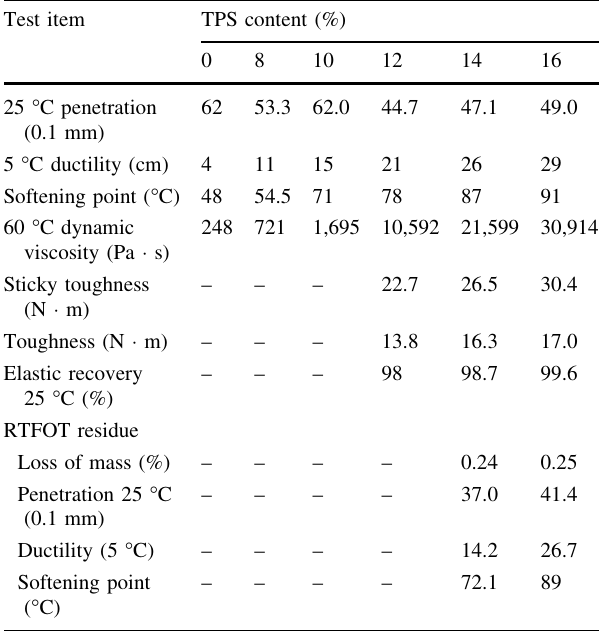
Table 7 Properties of local #70 grade asphalt with different contents of TPS Test